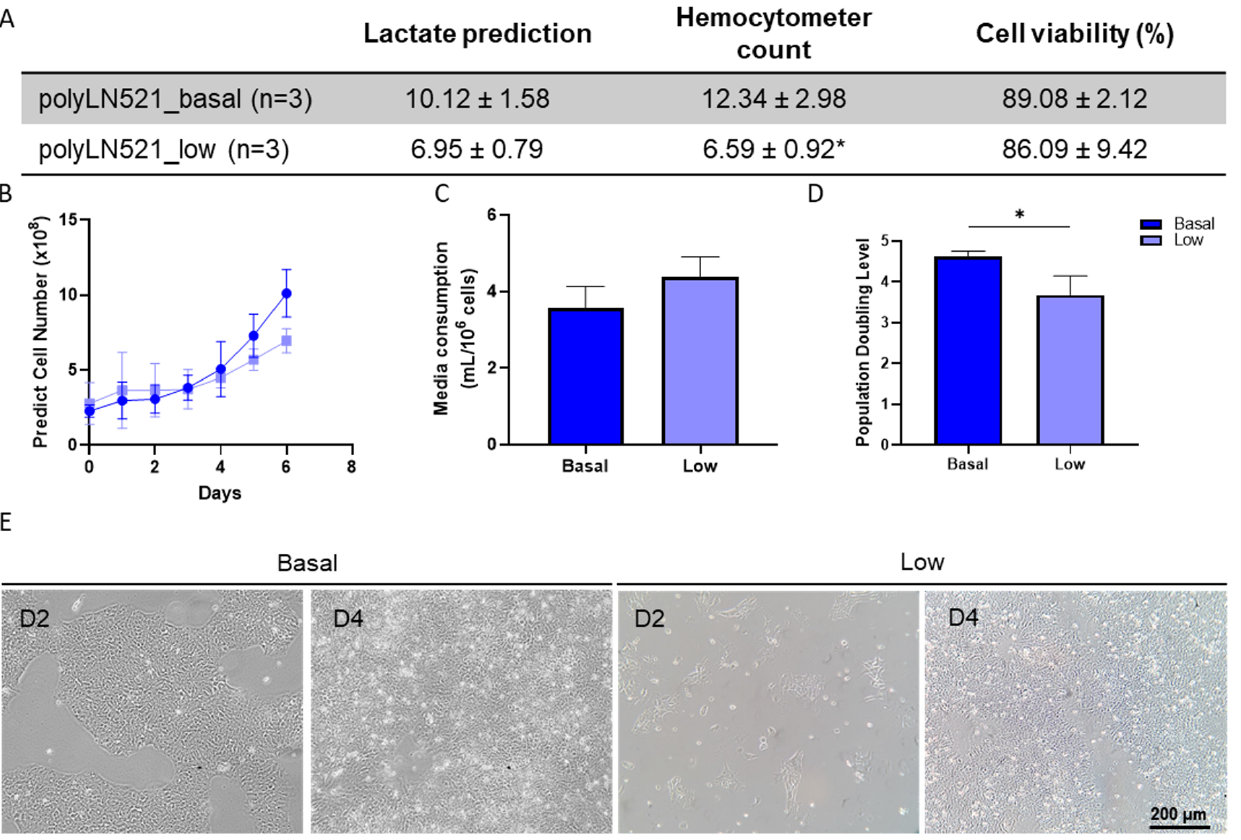
Figure 6. Large-scale expansion of human induced pluripotent stem cells (hiPSCs) using polyLN521. ( A ) Comparison between lactate-predicted and hemocytometer-counted cells harvested from the quantum expansion system (QES) after 6 days of expansion (data expressed in millions of cells). * p < 0.05, hemocytometer count for basal-polyLN521 vs. low-polyLN521. ( B – D ) Large-scale expansion characterization showing the lactate-predicted cell number ( B ), media consumption ( C ) and population-doubling level ( D ) of hiPSCs during expansion in QES on basal- and low-polyLN521 substrates. ( E ) Bright-field images of hiPSCs cultivated on basal-polyLN521 and low-polyLN521 after harvesting from the QES. * p < 0.05.